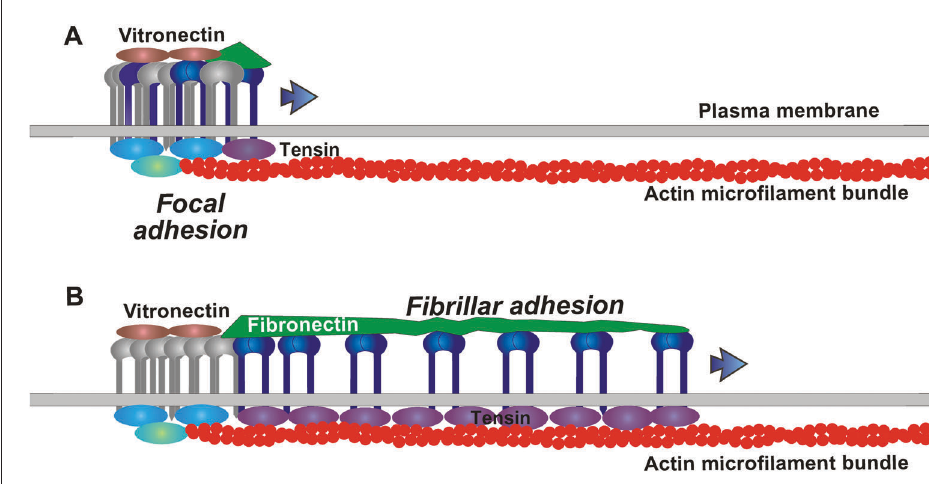
Figure 1. Integrin translocation mechanism for fibronectin ma- trix assembly. Cells use focal ad- hesions as anchors, e.g., for me- diating strong adhesion to vitro- nectin using the α V ß 3 integrin (A). Intracellular contractility and dynamic, directional movement of the α 5 ß 1 integrin (blue) along actin microfilament bundles from the cell periphery towards the cell center results in a pull- ing and stretching of fibronec- tin. The tension from stretching is thought to cause local unfold- ing of the fibronectin molecule, which exposes cryptic binding sites for assembling a linear fi- bronectin fibril (B). This process requires the cytoskeletal protein tensin and intracellular actomyo- sin